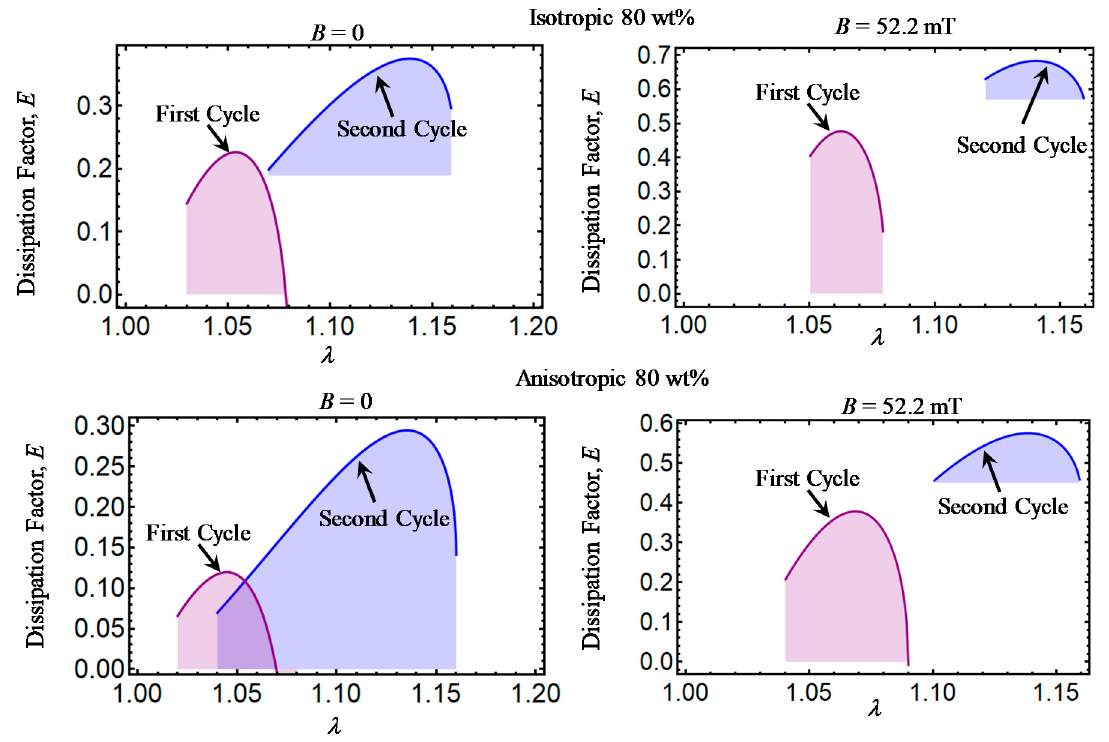
Figure 10. Dissipation factor curves for magnetorheological material samples made with a concentration of 80 wt% of CIPs.